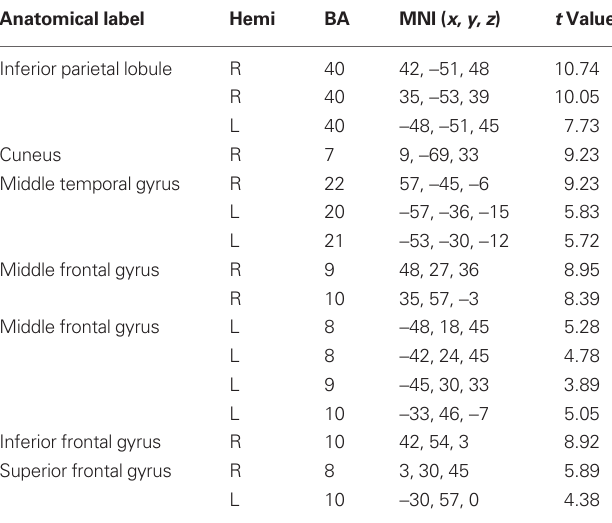
Table 3 | fMRI peak values for RSN 2 dorso-lateral attention network.